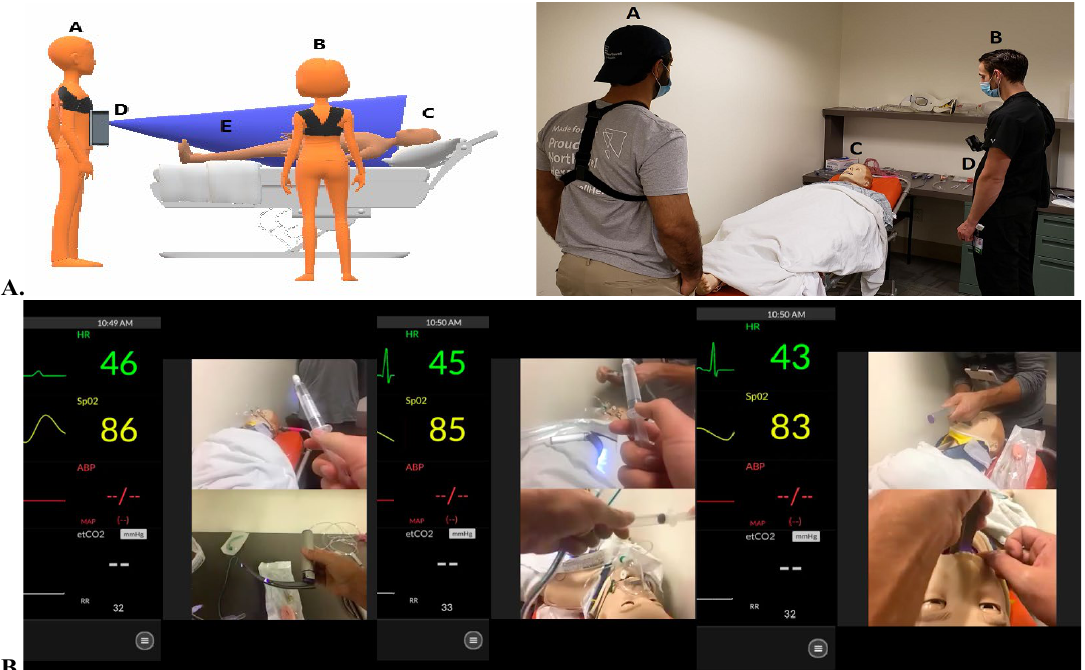
B. Figure 1. A. Conceptual framework for first-person perspective avatar (FPA) virtual simulation with body cameras. Key: (a, b) FPA;